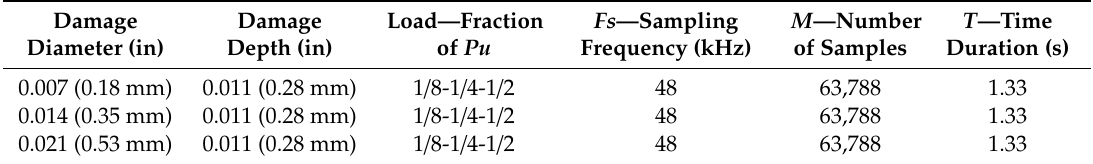
Table 3. Contact pressure data specifications.